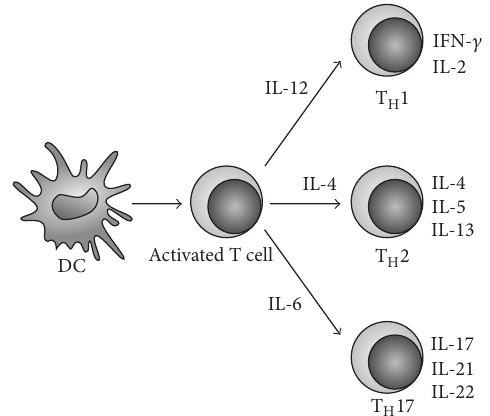
Figure 2: Causes of impaired Treg cells function in autoimmu- nity development. Failures of regulatory T (Treg) cell-mediated Figure 1: Differentiation of na¨ıve T helper cells into particular regulation can include: inadequate numbers of Treg cells owing to 0) subsets. T helper lymphocytes leaving the thymus (na¨ıve or T H their inadequate development in the thymus, for example, due to are not yet fully differentiated to perform their specific functions in a shortage of principal cytokines (IL-2, TGF- 𝛽 ) or costimulatory peripheral lymphoid tissues. They are endowed of these properties signals (CD28), and so forth. Further, the number of Treg cells in the process of their interactions with dendritic cells (DCs) that can be in a physiological range; however, there are some defects engulf, process, and present antigens to them. Moreover, DCs in in Treg-cell function that are intrinsic to Treg cells, for example, dependence of theprocessed antigens producedifferentcytokines. If they do not synthesise sufficient quantity of immunosuppressive 1 subset, if IL-4 DCs produce IL-12, na¨ıve T cells polarise into the T H cytokines (IL-10, IL-35, and TGF- 𝛽 ), or there is a breakdown of their 2 subset and eventually, if DCs synthesise IL-6, na¨ıve T into the T H interaction with effector T cells. Ultimately, pathogenic effector T 17 cells. helper cells will become the T H cells (Teff) are resistant to suppression by Treg cells owing to factors that are intrinsic to the effector cells or factors that are present in the inflammatory milieu that supports effector T cells